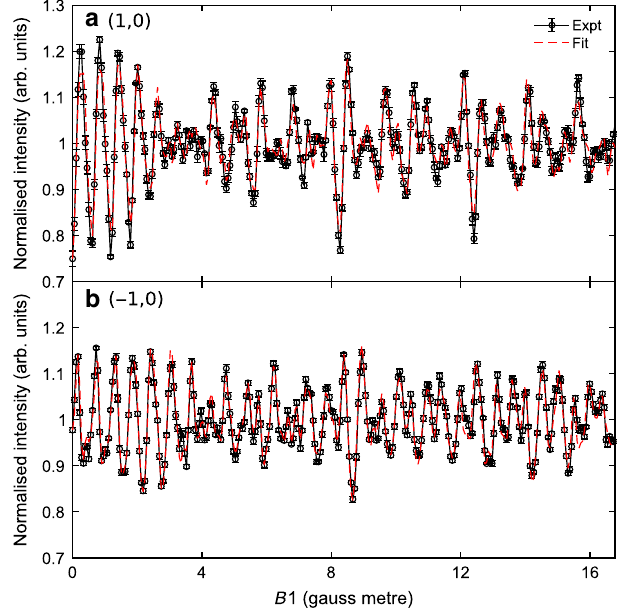
Fig. 3 Experimental data and fi ts. a The normalised intensity of H 2 scattered from LiF(100) into the (1,0) diffraction channel as a function of the applied fi eld integral in the fi rst electromagnet, B 1, for B 2 = 0 G m (black circles) and the fi t to the data (red dashed lines). The error bars represent standard errors from repeated B 1 scans. b As for panel a, but for H 2 scattering into the ( − 1,0) diffraction